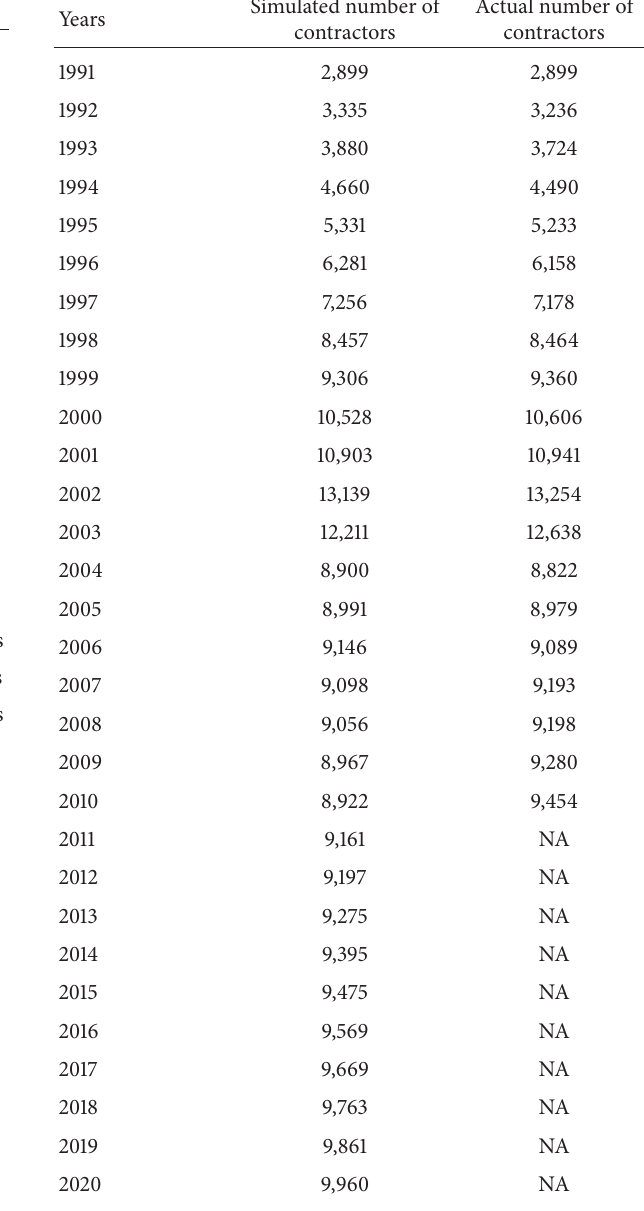
Table 2: The meaning of variables used in the contractor rating system.